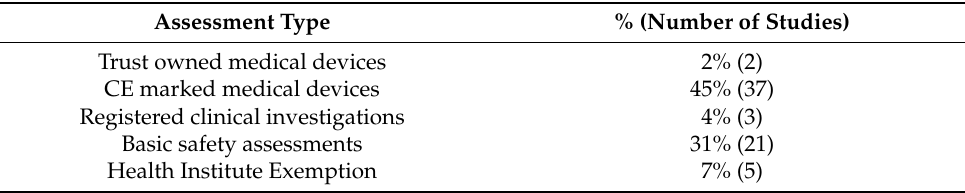
Table 2. Percentage and number of studies GSTFT received in 2019 under different assessment types.